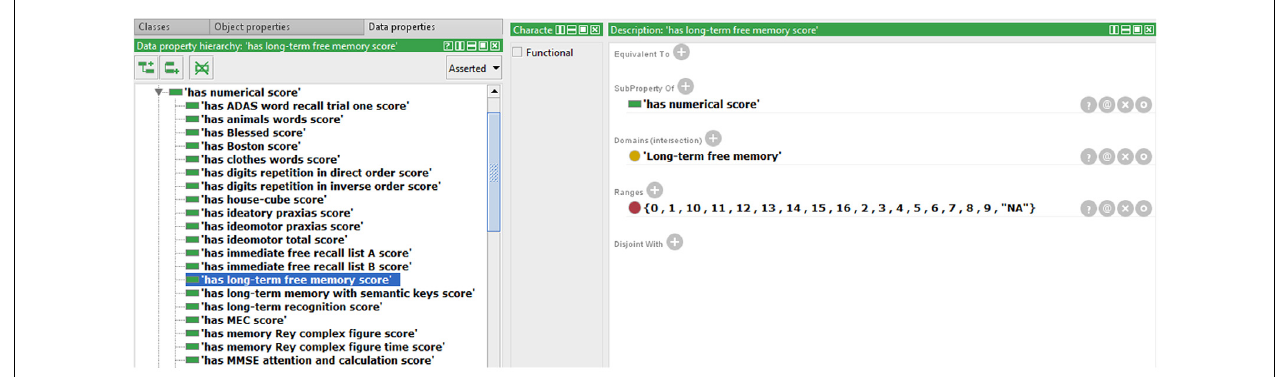
FIGURE 2 | Example of defining a new data property element with its domain and